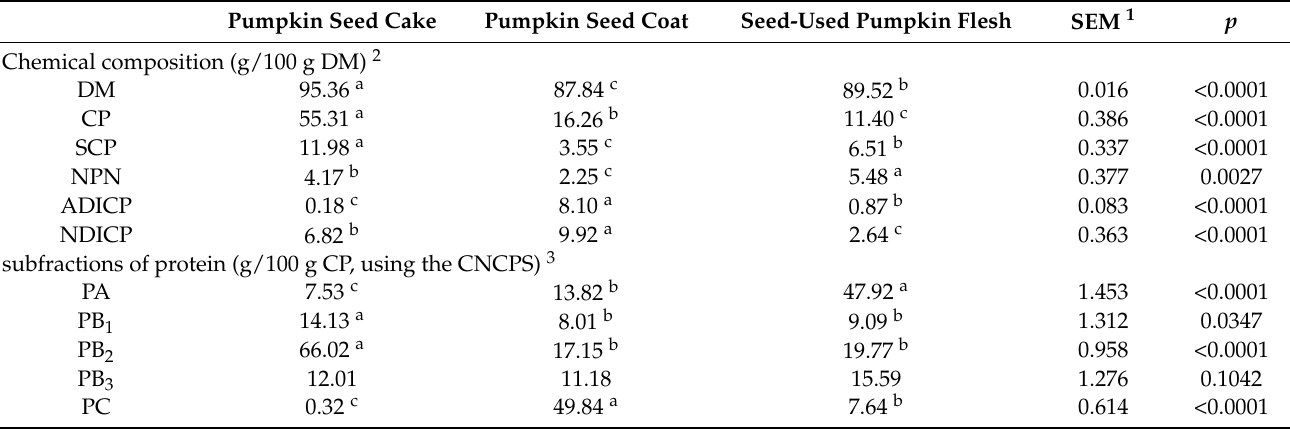
Table 1. Chemical profiles and protein subfractions in different byproducts of seed-used